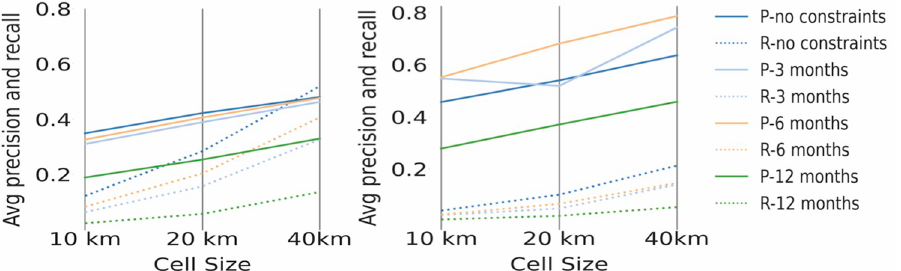
Fig 5. Average precision and recall comparison per cell size and temporal restriction: One by one analysis (left), three by three analysis (right) where ‘P’ refers to precision and ‘R’ refer to recall. In the figure ‘no constraints’ refers to the analyses performed with no temporal